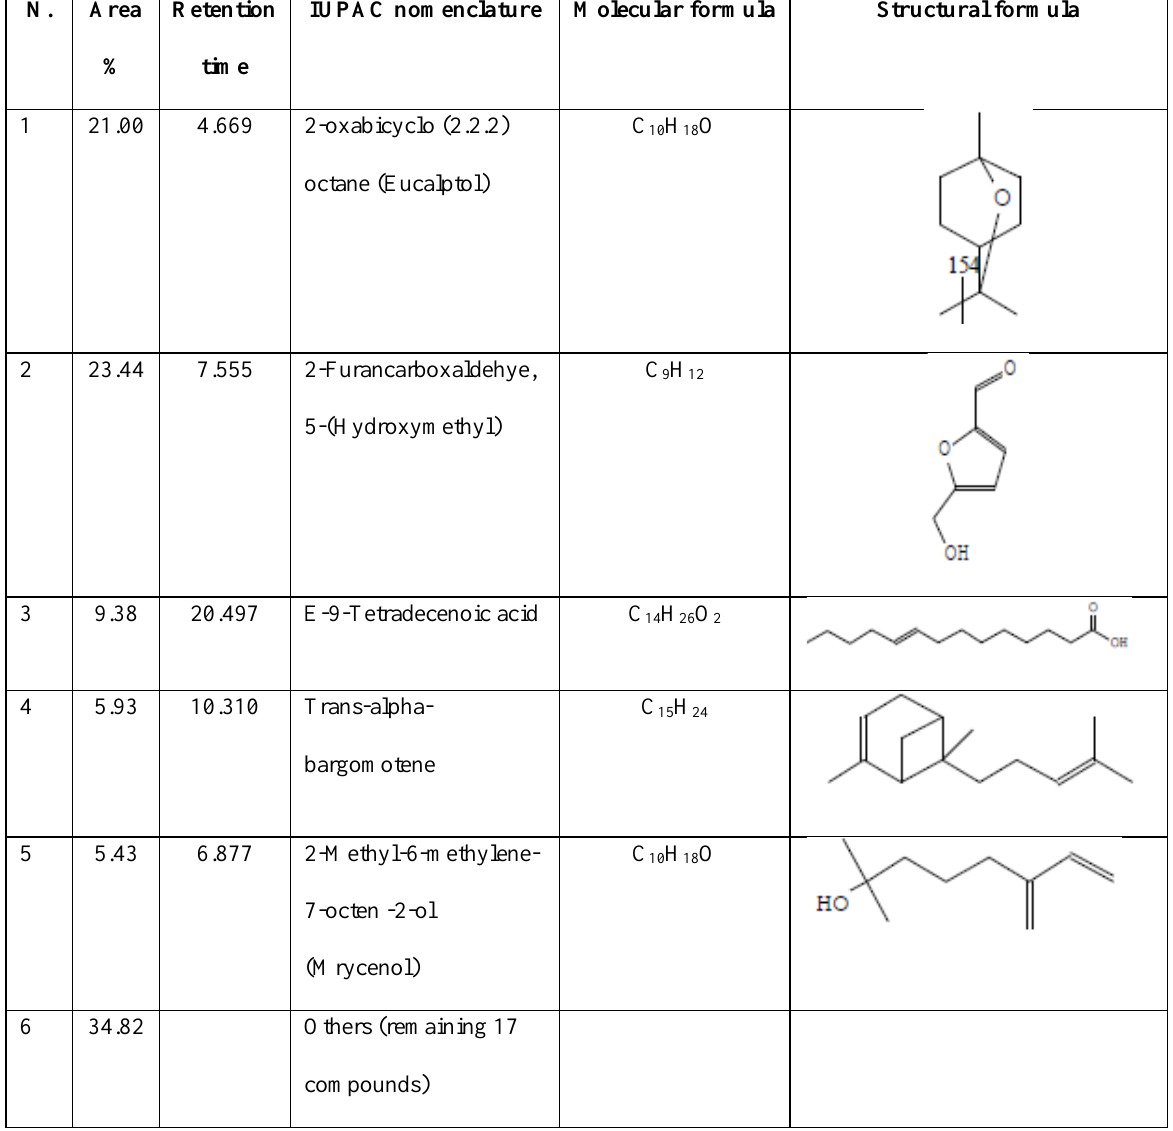
Table 5. Gas chromatography mass spectrometry analysis on C.sinensis leaves methanolic extract. Twenty two (22) compounds were identified in the preliminary GC-MS analysis with the major ones being.